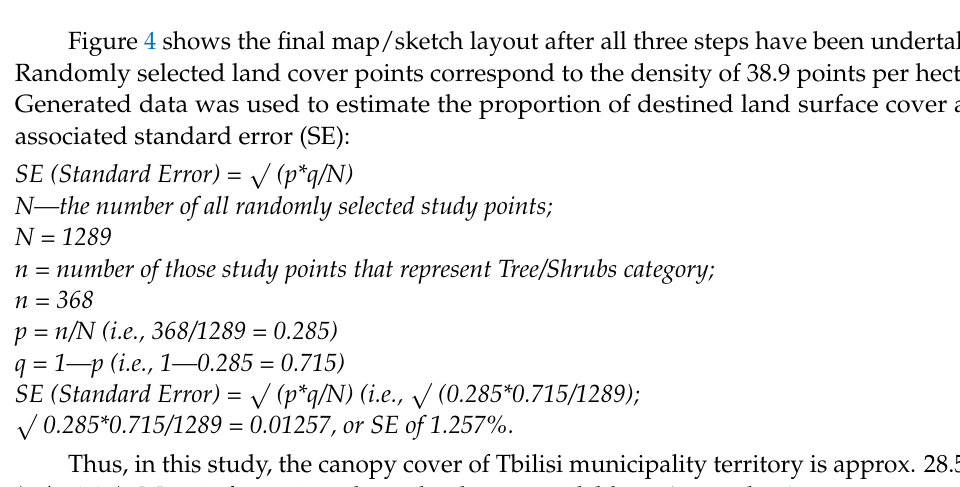
Figure 4. Distribution of land cover classes in Tbilisi municipality in current boundaries (prepared with i-Tree Canopy tool v.7 [35,36], indicating 1289 randomly selected study